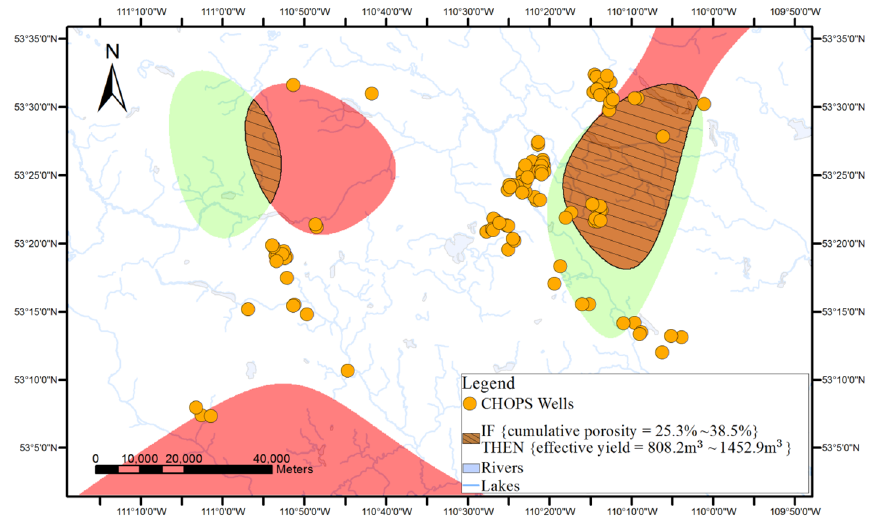
Figure 11. Surface-based geovisualization based on Trend interpolation of IF {cumulative porosity = 25.3%–38.5%} THEN {effective yield = 808.2–1452.9 m 3 }.